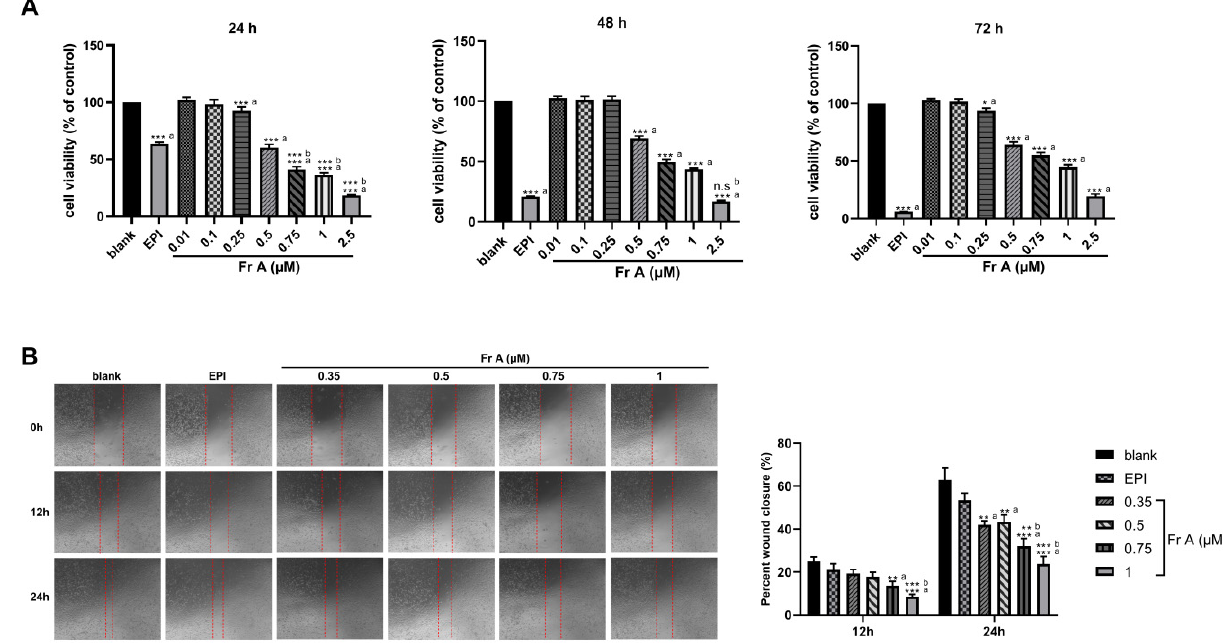
Figure 1. Inhibitions of cell viability and migration by Frondoside A (Fr A). Exponentially growing UM-UC-3 cells were treated with the indicated concentrations of Frondoside A for 24, 48, and 72 h ( A ). Cell viability was assayed as described in Materials and Methods. Frondoside A significantly suppressed the migration of UM-UC-3 cells, and cell mobility was measured at 0, 12, and 24 h (objective × 4) ( B ). Data are expressed as means ± S.E.M. * Significantly different at p < 0.05. ** Significantly different at p < 0.01. *** Significantly different at p < 0.001. n.s (not significant). “a” stands for versus blank control; “b” stands for versus EPI (10 μ M).